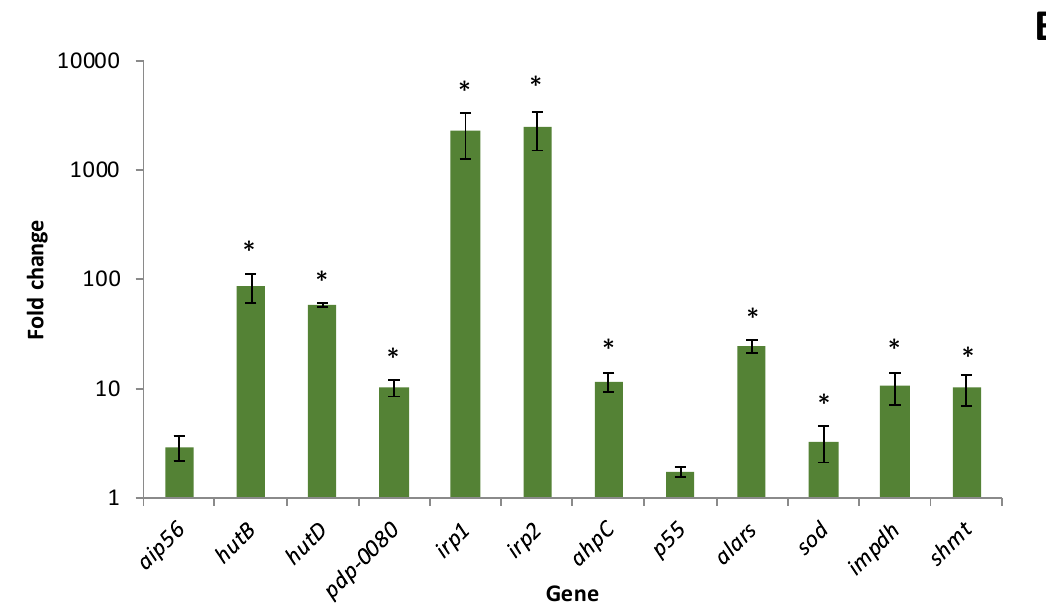
Figure 3. Relative transcription based on the 2 −ΔΔ C t method of Phdp genes in liver ( A ) and head kidney ( B ) of S. senegalensis specimens 96 hours post-infection. Data were normalized against 16S rRNA gene and Phdp cells grown in bacteriological media were used for fold change calculations. Values represent the mean ± SEM of three fish. Significant differences ( p < 0.05) compared to in vitro grown bacterial cells have been indicated with an asterisk (*).